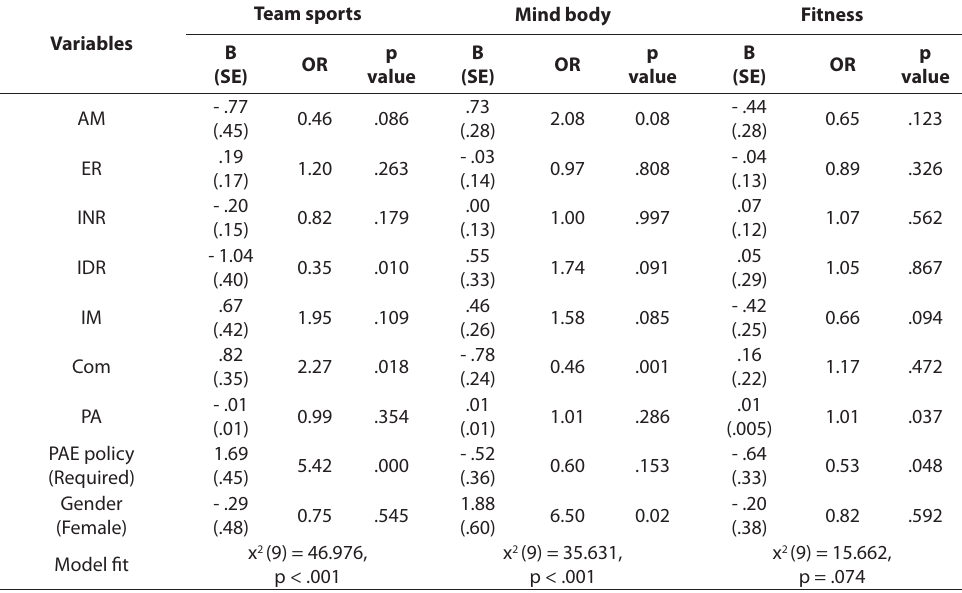
TABLE 2 Results of logistic regression analysis for freshman’s enrollment in